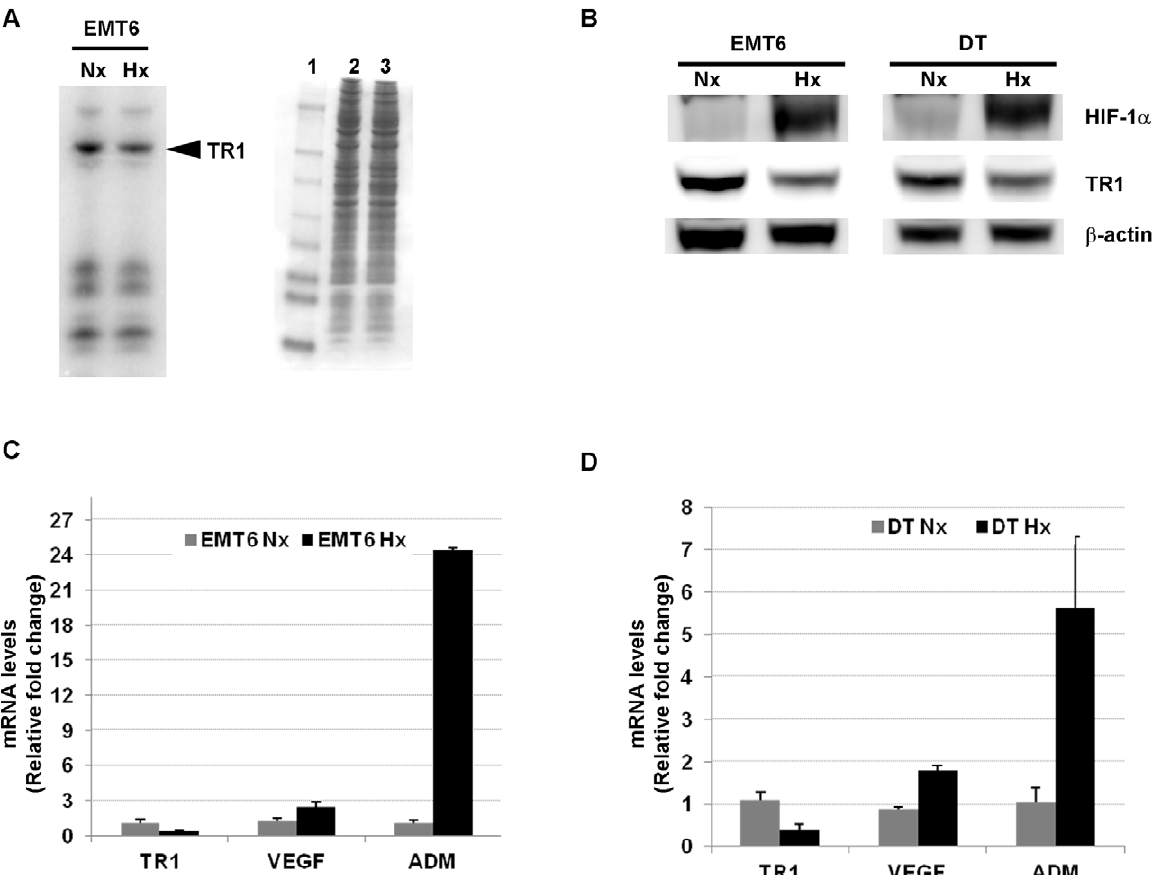
Figure 1. Effect of hypoxic conditions on TR1 mRNA and protein levels. (A) EMT6 cells were labeled with 75 Se and incubated under normoxic (Nx) or hypoxic (Hx) conditions for 12 h. Cells were lysed and selenoprotein levels analyzed by autoradiography (left panel). Protein standards are shown in lane 1 and protein extracts of EMT6 cells cultured in (lane 2) normoxic or (lane3) hypoxic conditions (right panel). (B) TR1 protein levels were analyzed by western blotting in EMT6 and DT cell lines grown under normoxic (Nx) or hypoxic (Hx) conditions for 12 h. (C) EMT6 and (D) DT cell lines were grown under normoxic (Nx) or hypoxic (Hx) conditions and the mRNA levels of TR1, VEGF and ADM determined by quantitative RT-PCR and normalized to the content of b -actin mRNA in the same sample. The data represent the fold induction of each mRNA over the mean from the normoxic values. The mean from 3 different experiments 6 SE is shown.